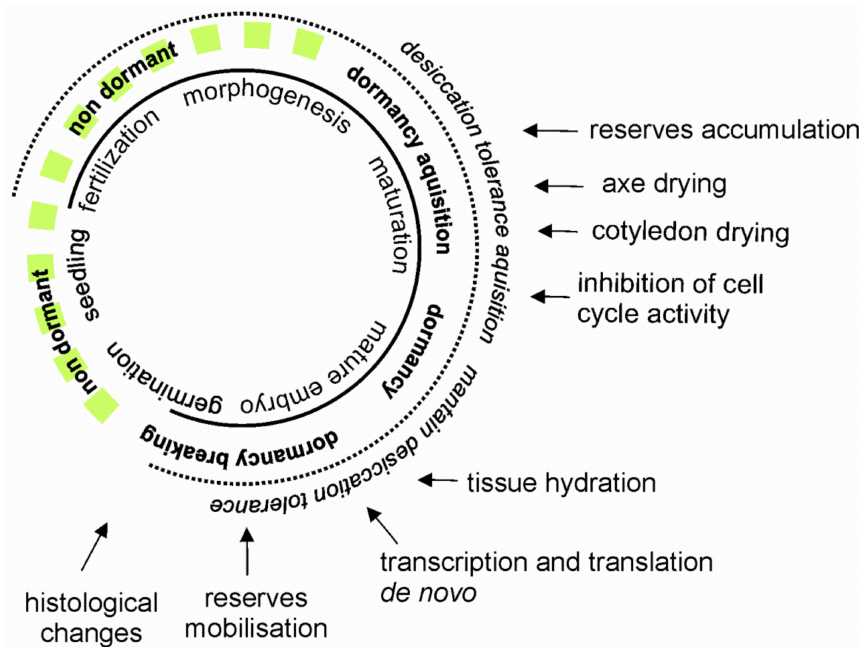
Figure 1. Subsequent phases that occurs in seeds. Inside the ring, developmental processes from fertilization through morphogenesis, maturation to germination are shown. Outside the ring, physiological aspects accompanying the seed development are shown in relation to desiccation tolerance (italic) and dormancy (bold). Arrows indicate each moment of seed development as it occurs, e.g., accumulation of reserves, axe and cotyledon drying, transcription de novo, and reserves